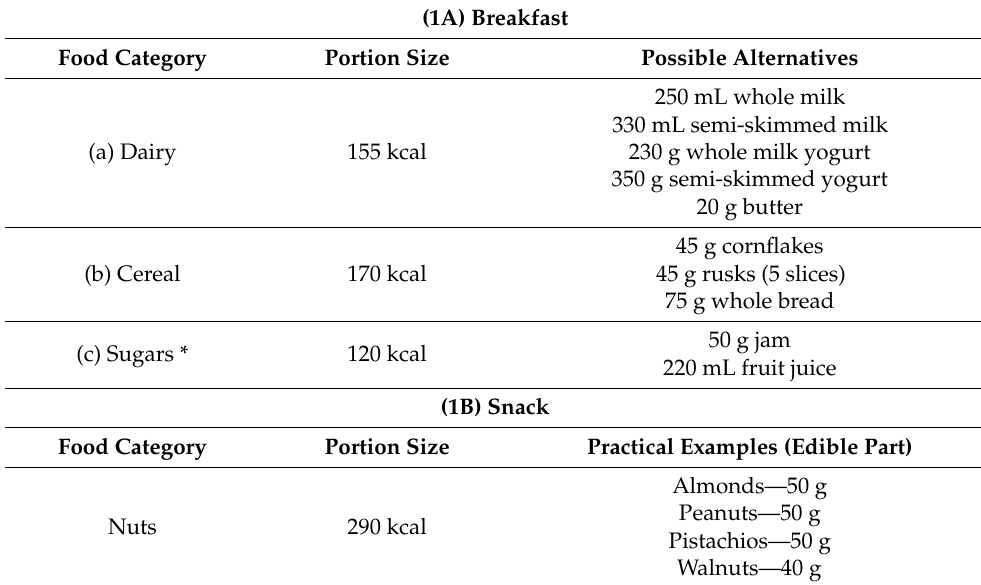
Table 1. Reference scheme for breakfast and snacks.